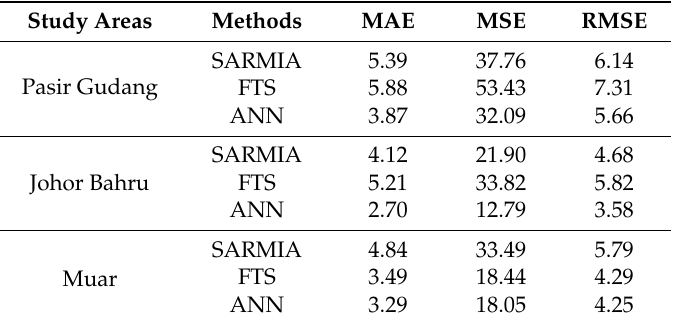
Table 9. Comparisons result with different forecasting